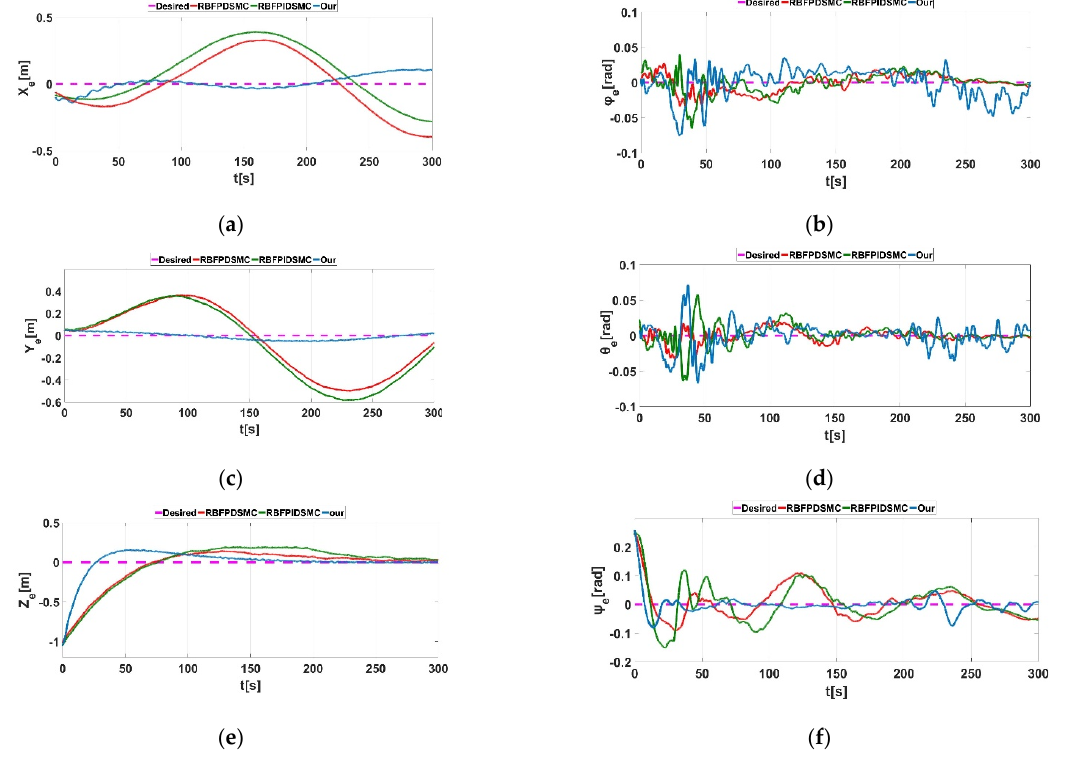
Figure 7. AUV position − tracking errors. ( a ) x e ; ( b ) ϕ e ; ( c ) y e ; ( d ) Θ e ; ( e ) z e ; ( f ) ψ e . Figure 8 shows the speed-tracking errors of six degrees of freedom: 𝑢 𝑒 , 𝑣 𝑒 , 𝑤 𝑒 , 𝑝 , and 𝑟 𝑞 𝑒 . We analyzed the velocity tracking error and found that (1) The velocity track- 𝑒 ing errors of the three methods could converge to a certain range of bounded regions.